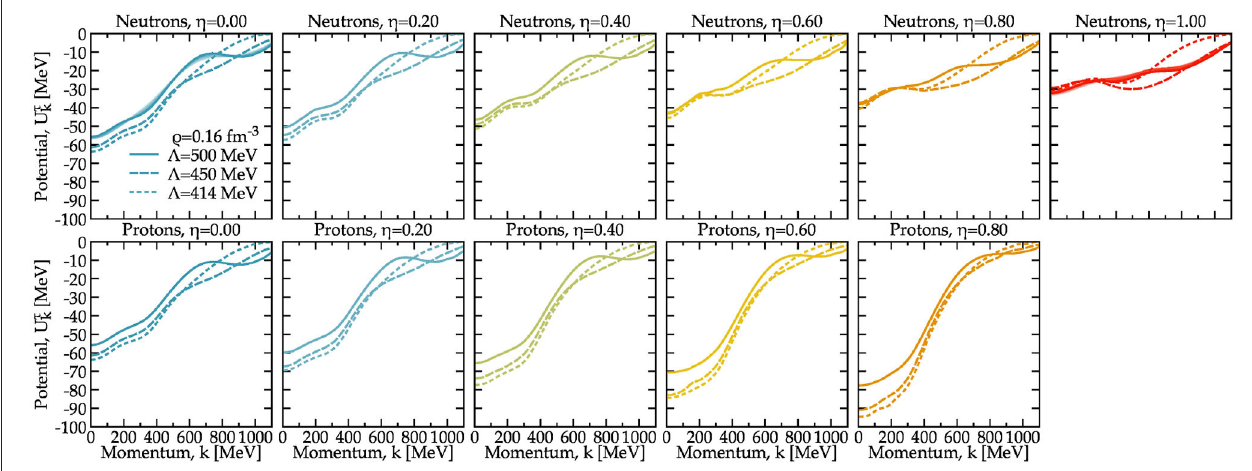
FIGURE 9 | Neutron (top) and proton (bottom) single-particle potentials as a function of the momentum for the three interactions considered in this work. The panels from left to right correspond to different isospin asymmetries, from η = 0 (symmetric nuclear matter, leftmost panel) to neutron matter (rightmost panel). The bands for the η = 0 and η = 1 obtained with the 3 = 500 MeV interaction highlight the temperature dependence from T = 20 to T = 0